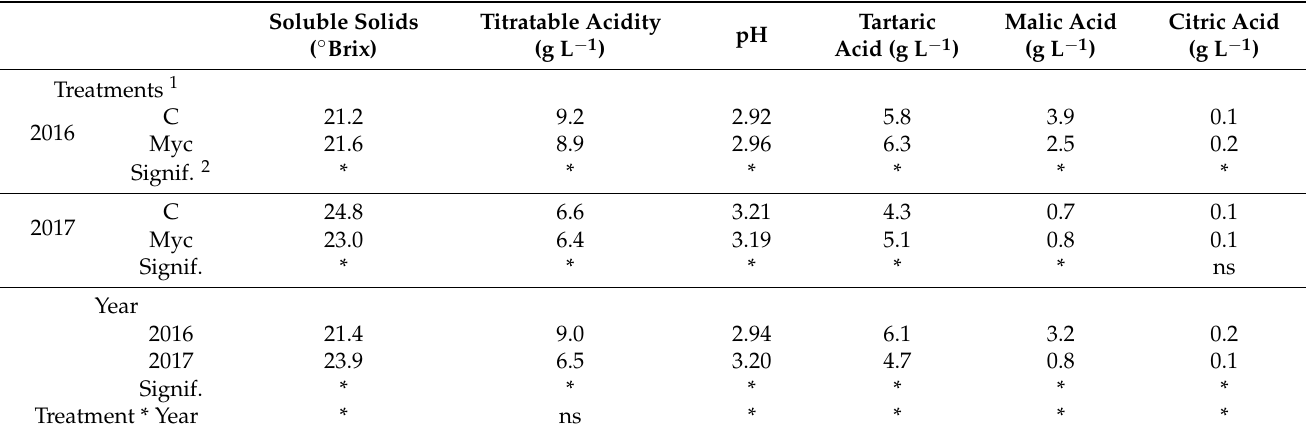
1 C indicates control treatment without mycorrhizal inoculation. Myc indicates treatment with mycorrhizal fungi inoculation. 2 Results of analysis of variance: * and ns indicate significance at p = 0.05 and not significant, respectively, within treatments and years (mean separation by Bonferroni correction at p ≤ 0.05).